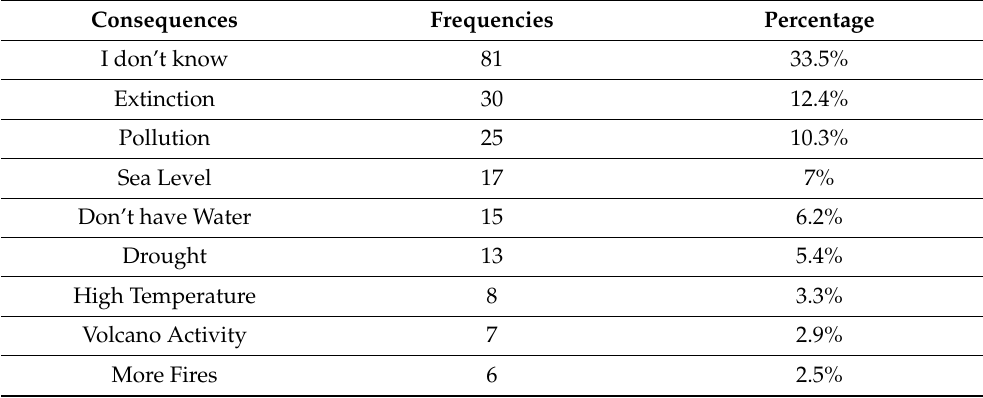
Table 4. Survey results of the consequences of climate change. N =